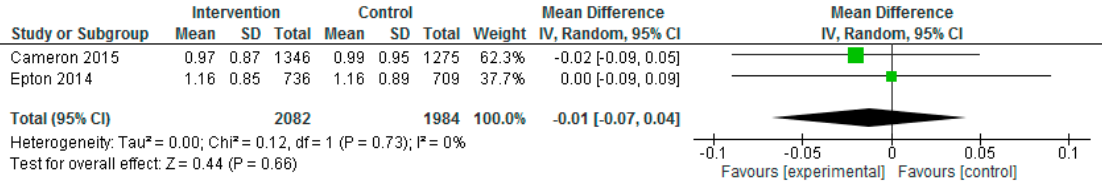
Figure 3. Meta-analysis of number of binge drinking episodes per week.